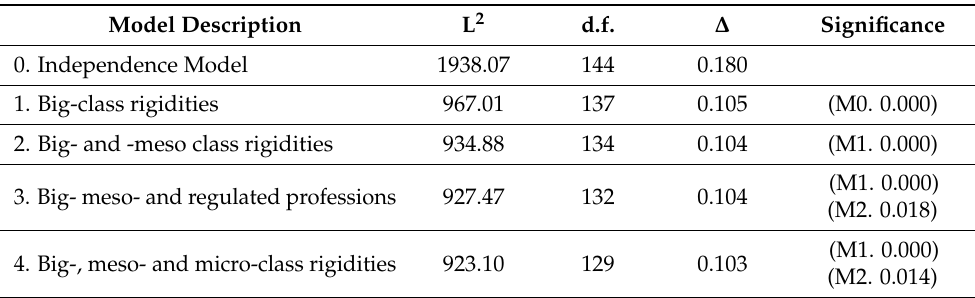
Table A7. Fit indices of log-linear model of quasi perfect mobility with Big-, Meso-, and Micro-class rigidities (men only 3840 valid